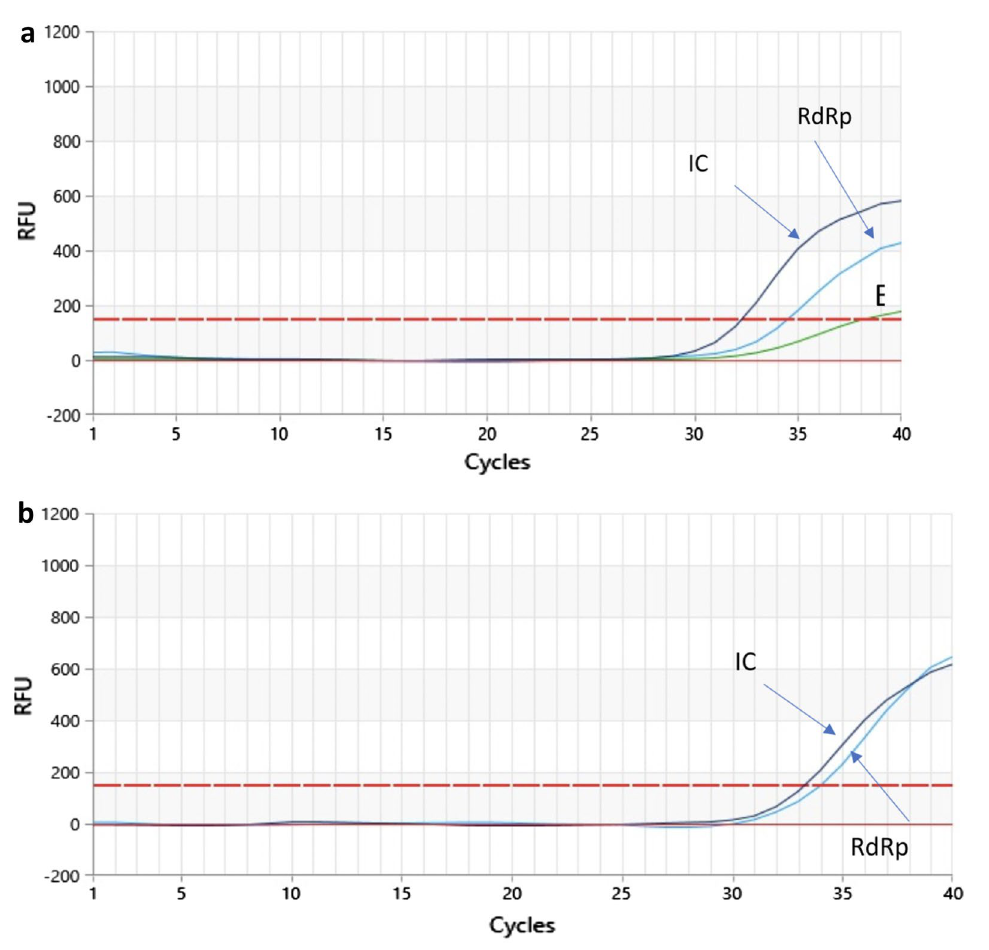
Figure 3. The figure illustrates the Results of qRT-PCR assays obtained using ZeptoMetrix panels. On y axis: Relative Fluorescence Unit (RFU); on x axis: threshold cycle (CT).